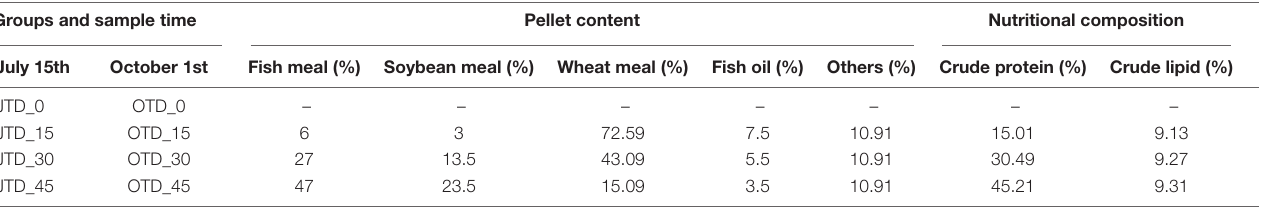
TABLE 1 | Composition and nutrient levels of the basal diet (as-feed basis,